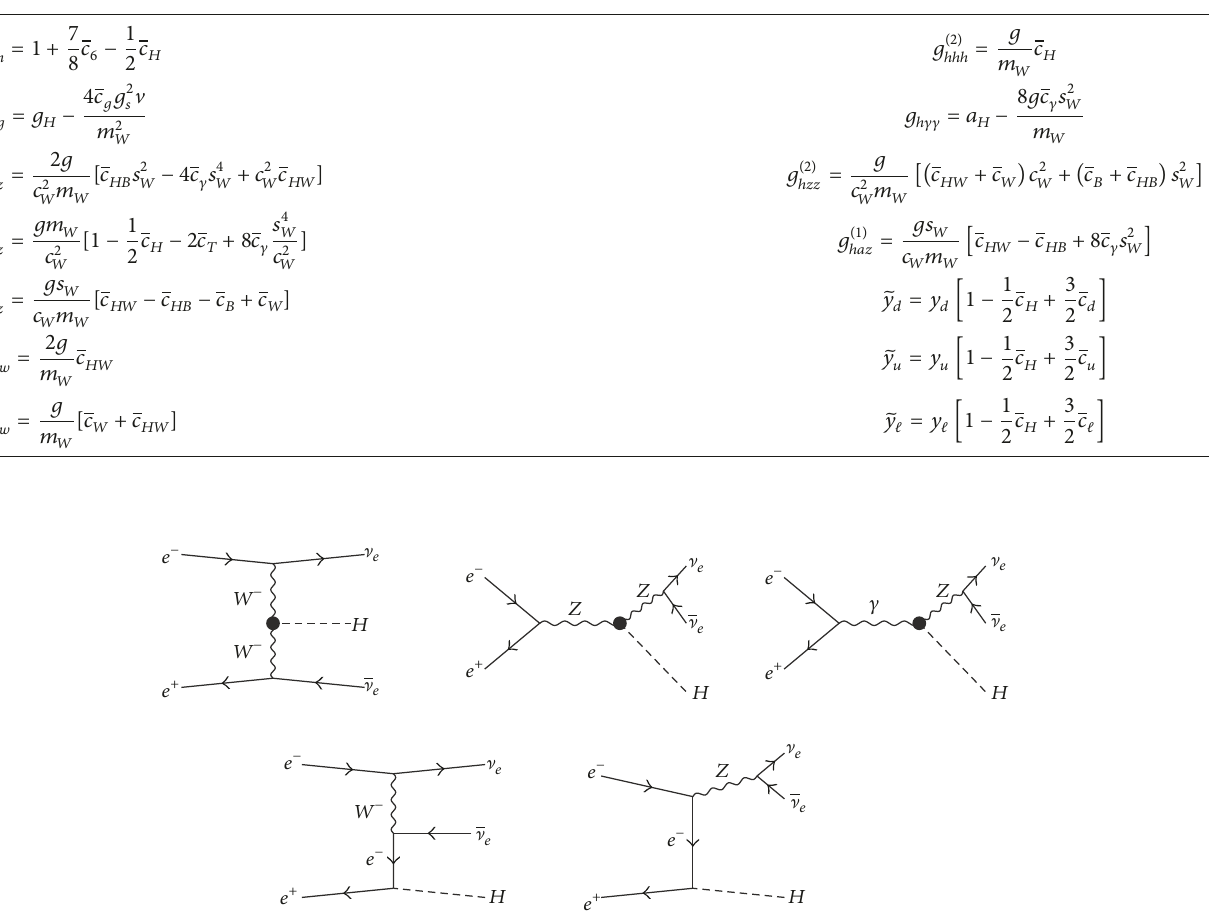
Table 1: The relations between Lagrangian parameters in the mass basis (see (2)) and the Lagrangian in gauge basis (see (3)) ( 𝑐 푊 ≡ cos 𝜃 푊 , 𝑠 ≡ sin 𝜃 푊 푊 ).